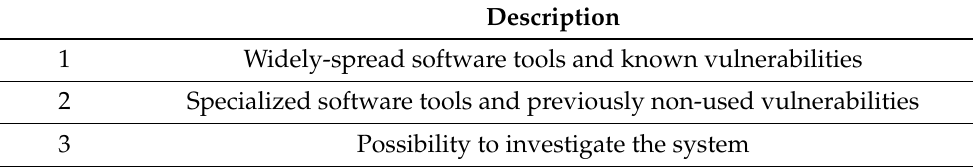
Table 4. Attacker types of